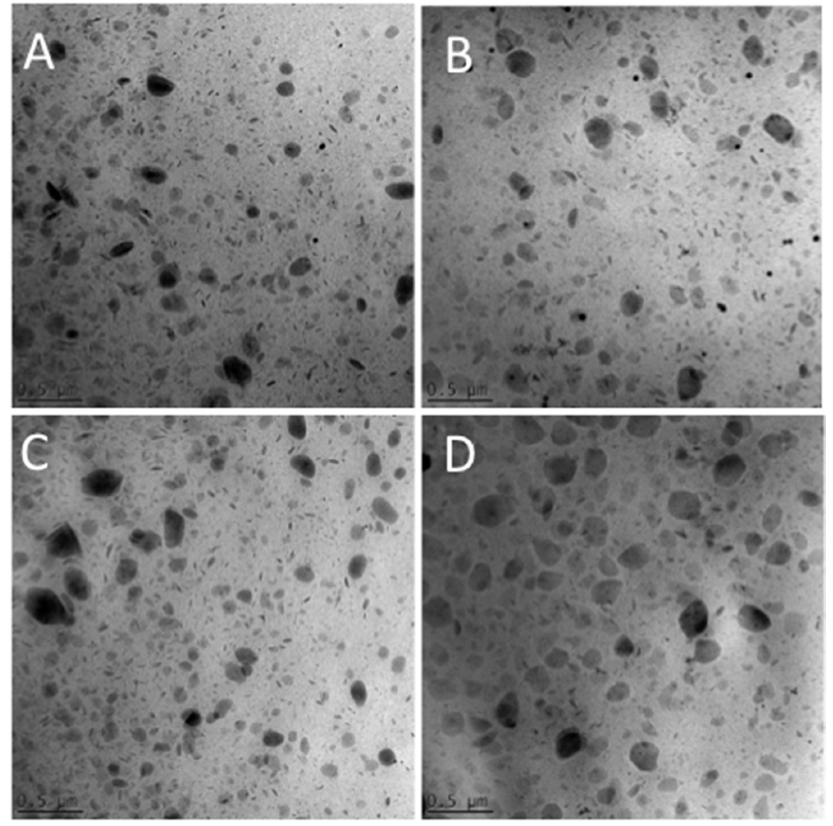
Figure 1. Cryo-transmission electron microscopy (cryo-TEM) images of e-NLC1 ( A ), NLC-EA1 ( B ), e- NLC2 ( C ), and NLC-EA2 ( D ). e-NLC2 ( C ), and NLC-EA2 ( D